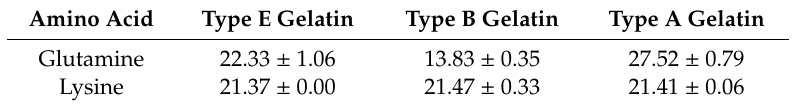
Table 2. Glutamine and lysine content (mmol / 100g) in type E gelatin, type B gelatin, and type A